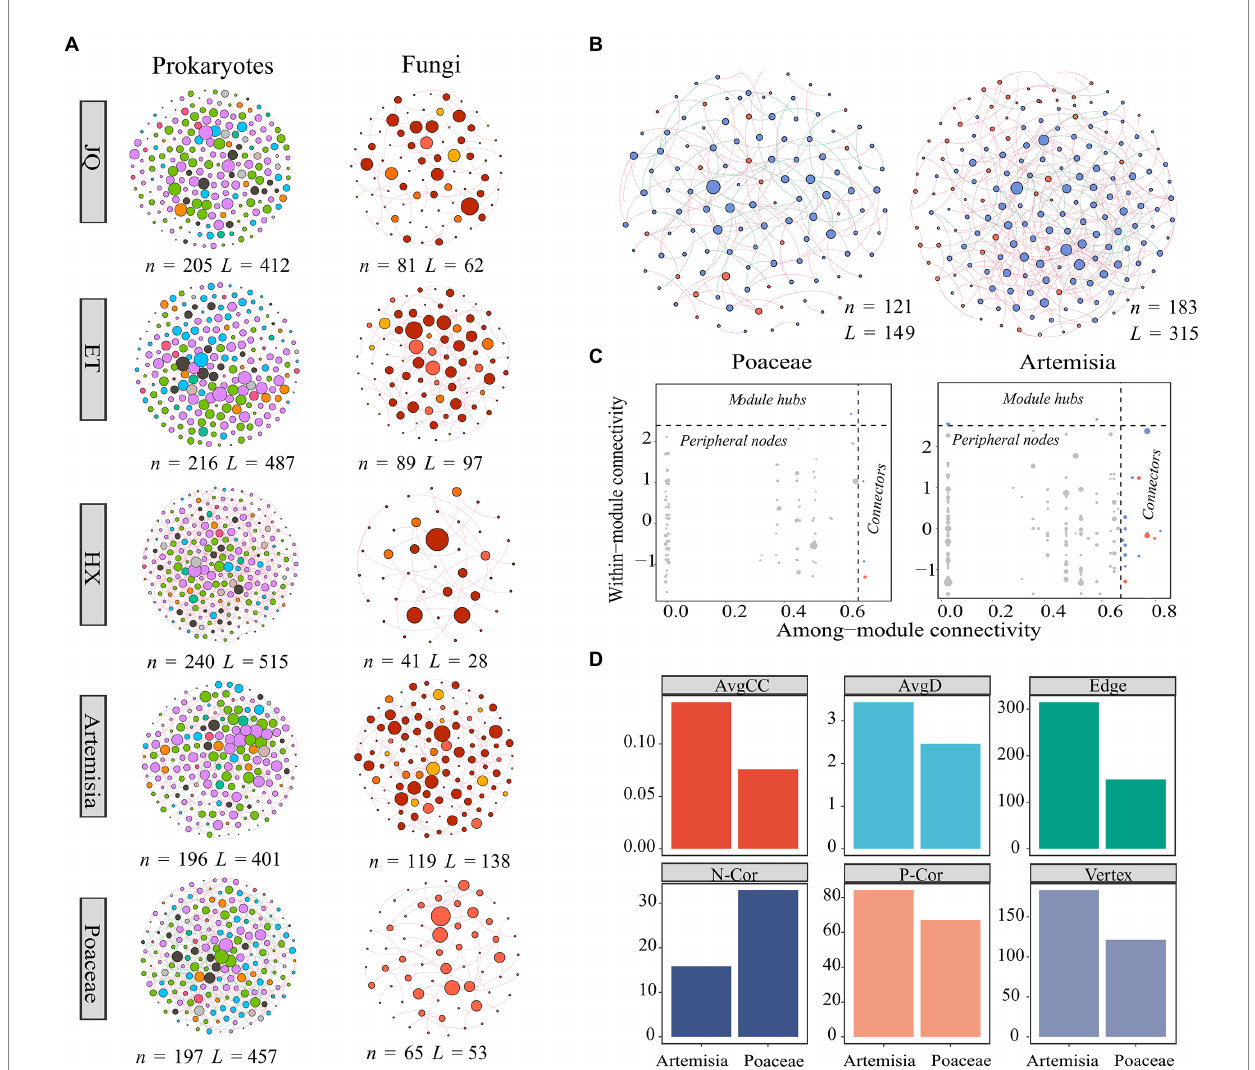
FIGURE 4 (A) Co-occurrence network of prokaryotic and fungal communities across three regions and two habitats. (B) Cross-kingdom co-occurrence networks of prokaryotic and fungal communities, blue nodes represent fungal taxa, and red nodes represent prokaryotic taxa. (C) Keystone nodes of cross-kingdom network. (D) Topological features of the cross-kingdom network. n indicates vertex, L indicates edge, AvgD indicates average degree, AvgCC indicates average cluster coefficient, Heter indicates network heterogeneity, N-Cor indicates the number of negative correlations, and P-Cor indicates the number of positive